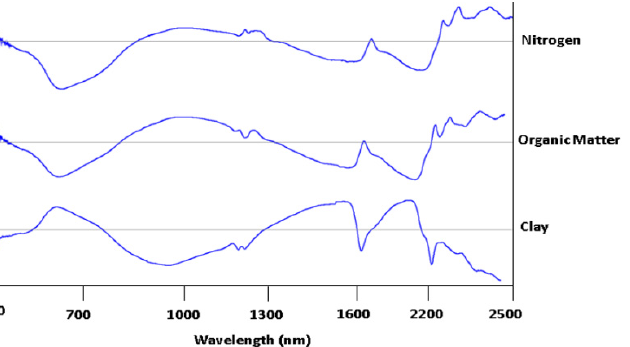
Figure 4. Weighted regression coefficient distribution over the spectral range obtained from PLSR. Black dotted lines represent zero correlation and have an offset by 1.0 units for clarity of presenta- tion.